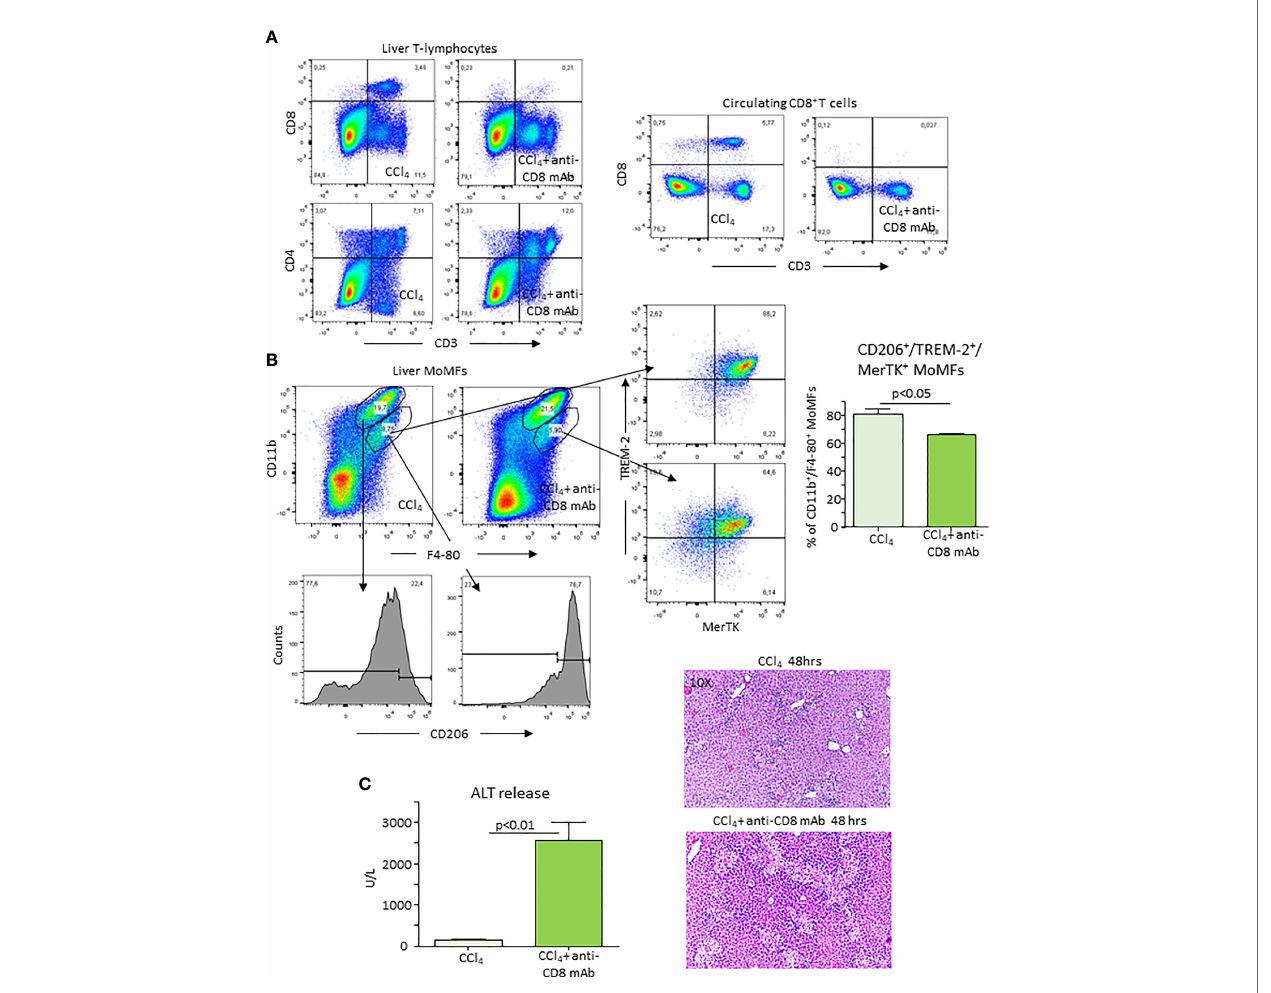
FIGURE 6 | Depletion of CD8 + T-lymphocytes lowers reparative MoMFs and impairs the resolution of acute liver injury. Mice were treated with an anti-CD8 monoclonal antibody (mAb) 72 hours before and immediately after CCl 4 administration and the evolution of hepatic injury was evaluated 48 hours after CCl 4 poisoning. The distribution of liver and circulating CD4 + and CD8 + T cells and that of hepatic CD11b + /F4-80 + MoMFs was monitored by fl ow cytometry in mice receiving CCl 4 (A) . The lowering of CD11b + /F4-80 + MoMFs induced by CD8 T-cell ablation involved CD206, TREM-2 and MerTK-expressing cells (B) . The effects of CD8 + T-depletion of the recovery from acute liver injury was evaluated by measuring alanine aminotransferase (ALT) release and histological analysis of liver sections stained with hematoxylin/eosin (magni fi cation 10X) (C)